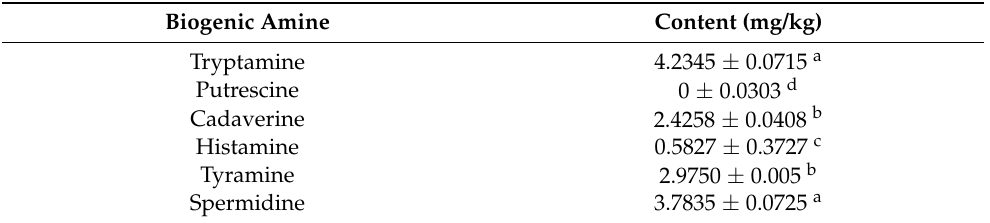
Bars with lowercase letter are significantly different ( p < 0.05) ( n =